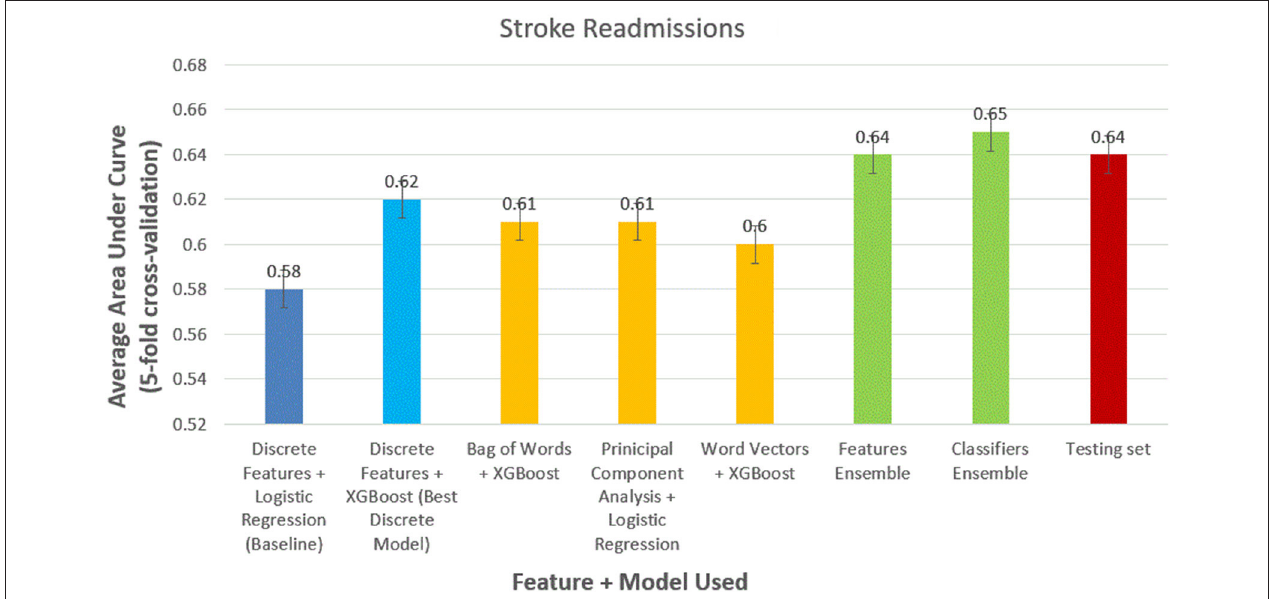
FIGURE 4 | Comparison of models to predict 30-day stroke